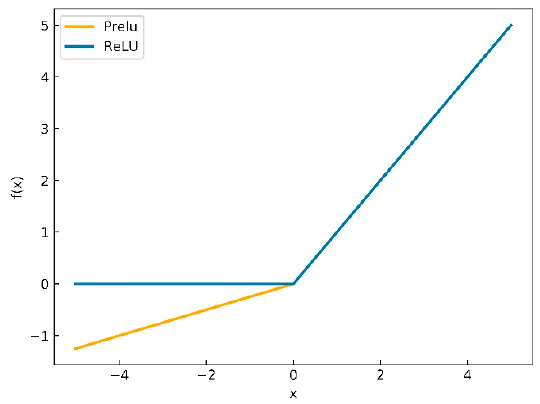
Figure 3. The curve of ReLU and PReLU equations.